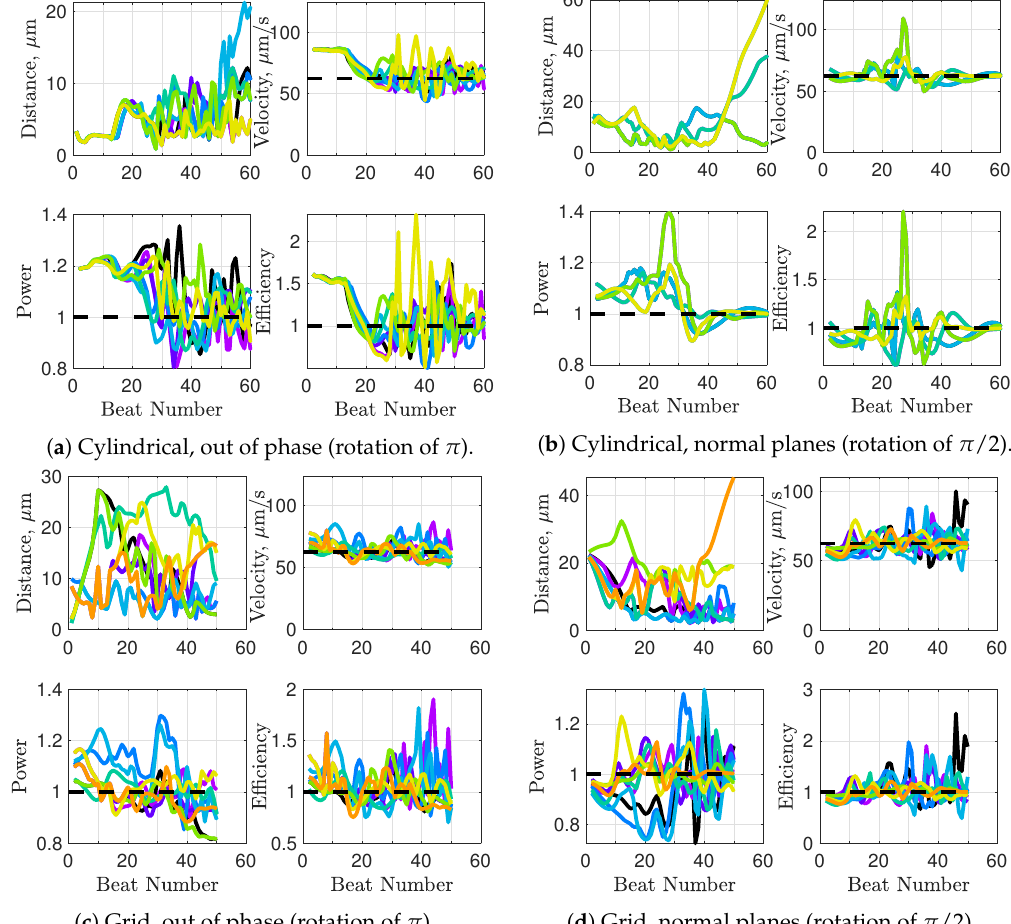
Figure 16. Phase differences between nearby neighbors. Comparison of minimal distances to other flagella, velocities, power, and efficiency with reference to individual swimmer in free space (dotted line). Color of curves indicates data for flagellum of matching color from initial configurations (see Figure 6a–c). Note that panels ( a , b ) only have 8 curves in order to exploit symmetries of